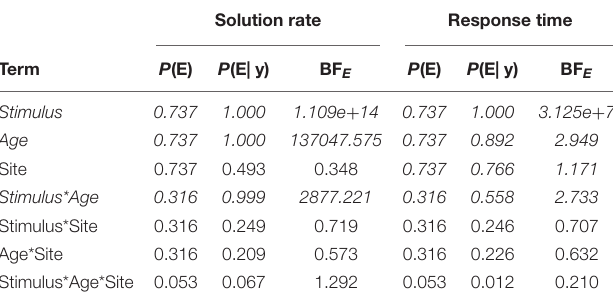
TABLE 3 | Results for all considered effects in the Bayesian model comparison for solution rate and response times. Solution rate Response time